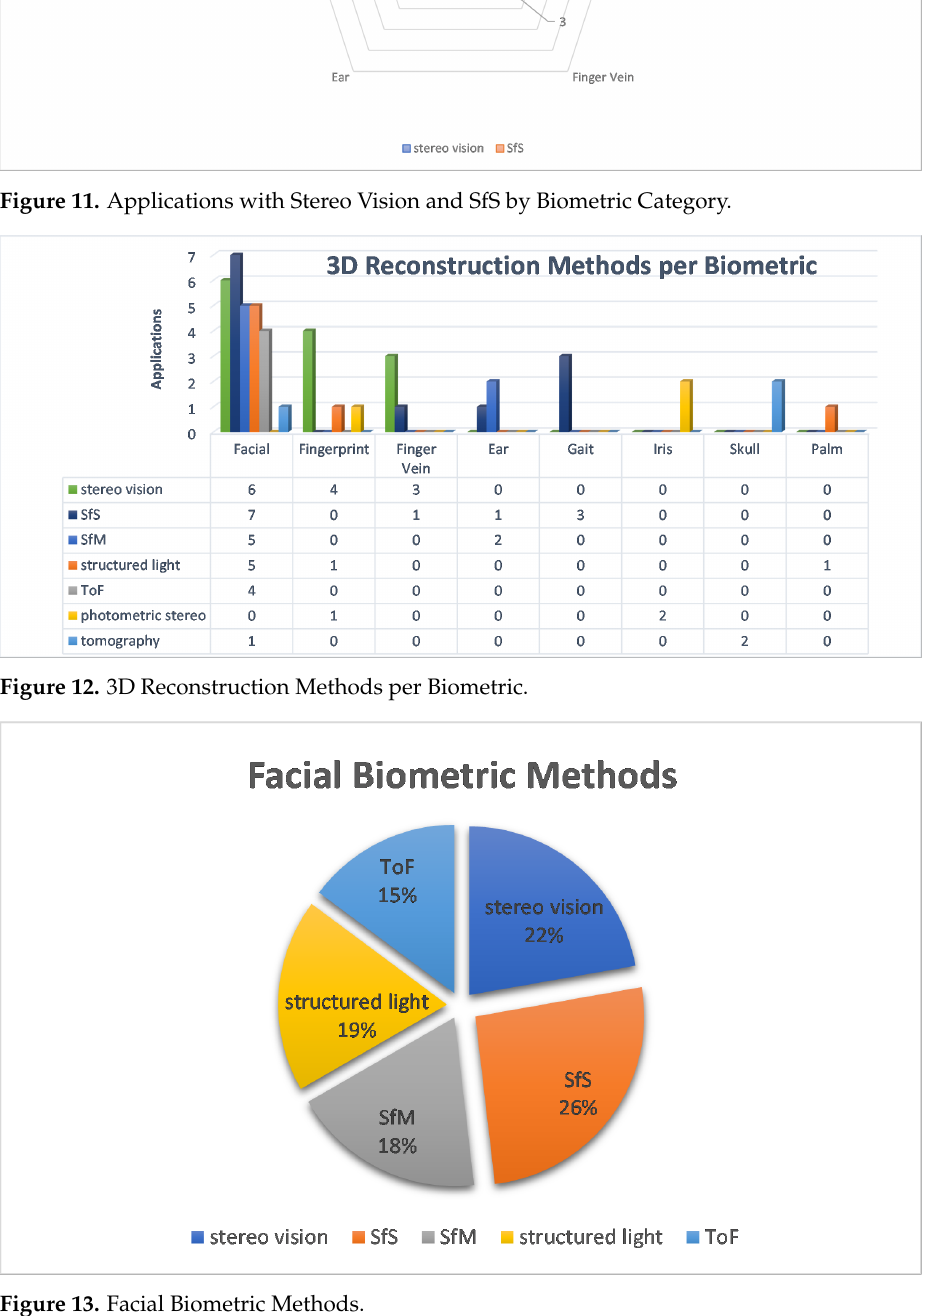
Figure 13. Facial Biometric